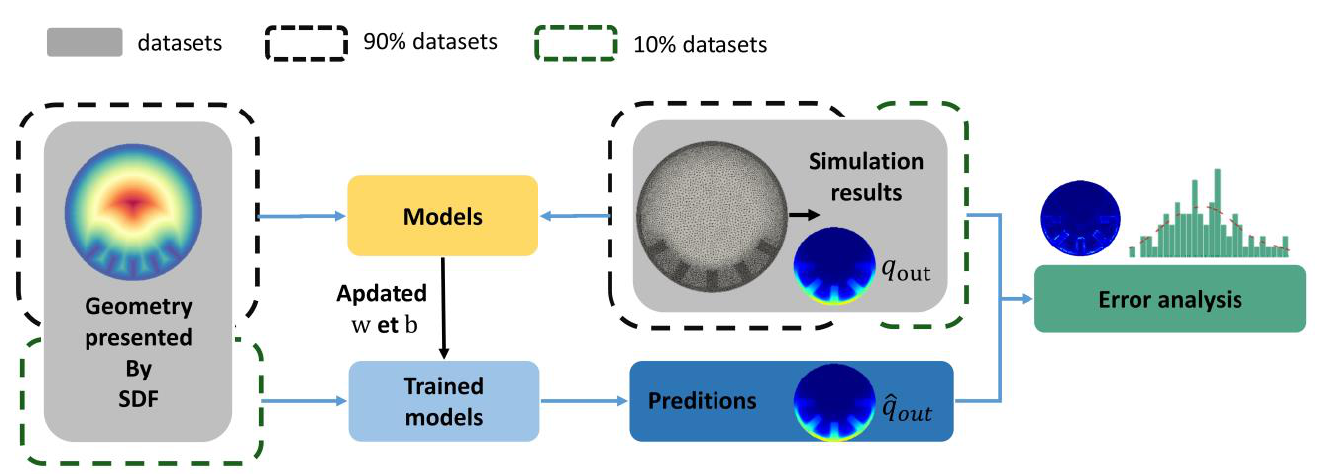
Figure 1. Workflow of proposed ROMs for temperature field and outlet heat flux predictions in rectangular finned absorber tubes.